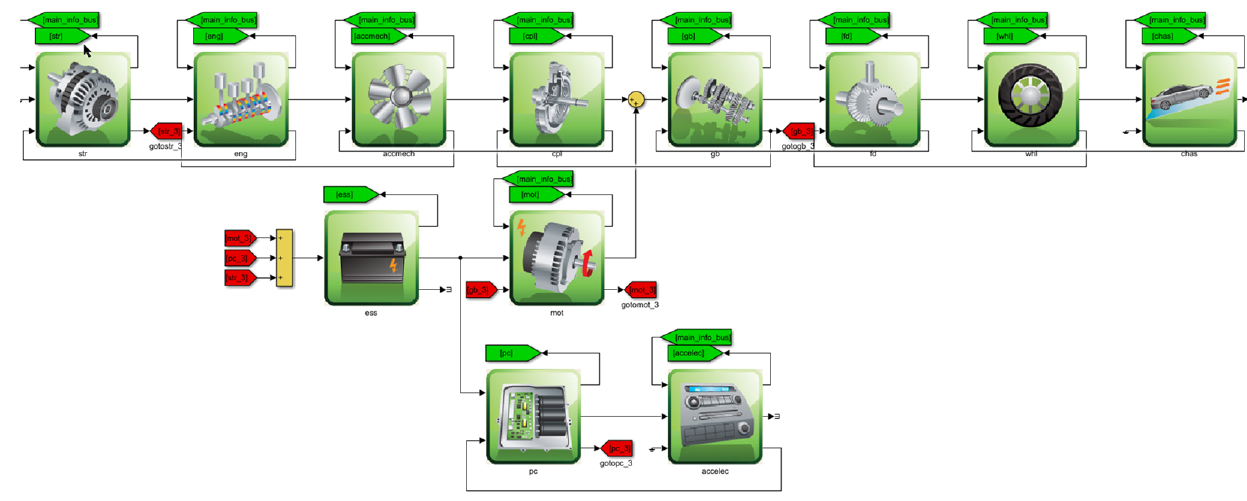
Figure 8. Autonomie simulation environment.